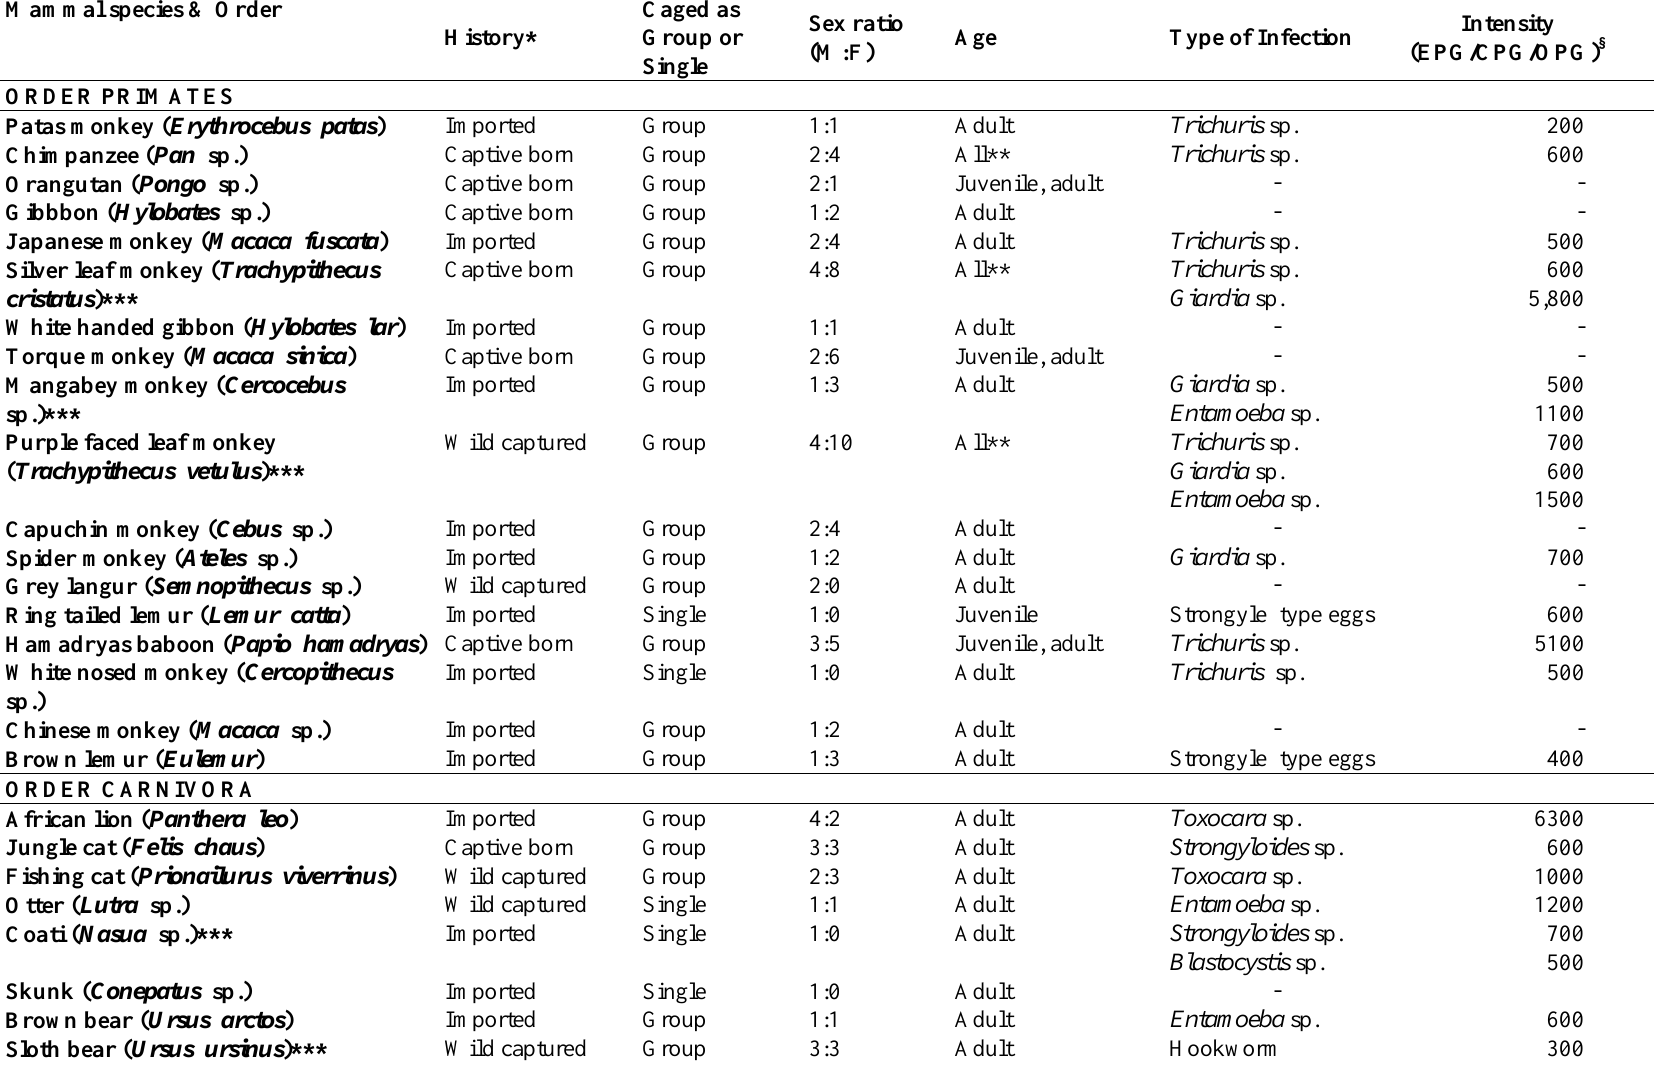
Table 1: Background information, type of gastrointestinal parasites and the intensity of infection in the mammal species at Dehiwala Zoo Mammal species & Order